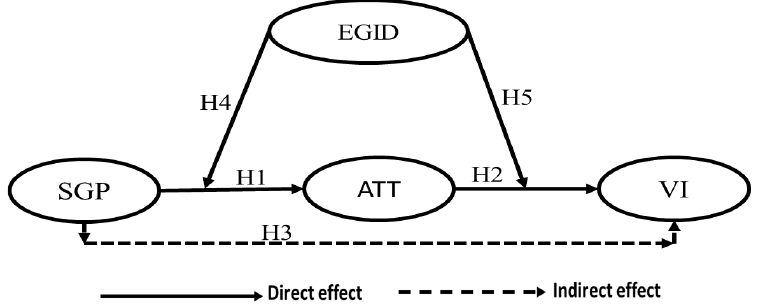
Figure 1. The suggested theoretical framework with hypotheses. SGP → Sustainable Gardening Practices; ATT → Consumer Attitudes Towards Green Hotel; VI → Green Hotel Visit Intention; EGID → Environmental Gardening Identity.